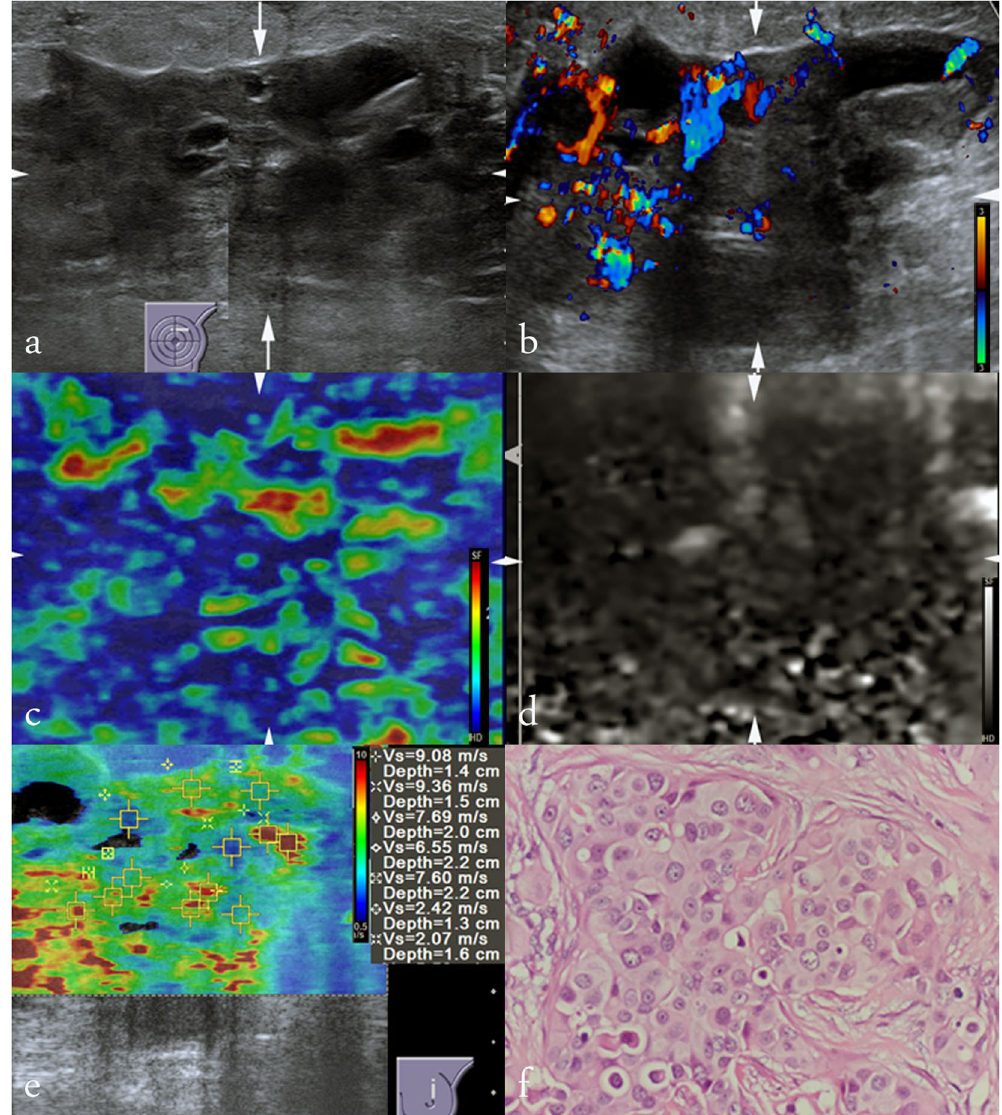
Figure 2. Images in a 42-years-old woman with invasive ductal carcinoma. At conventional US, an 68-mm breast lesion at 12 o’clock position of the left breast appears to be predominately solid, irregular shape, not parallel in orientation, not circumscribed margin, heterogeneous, enhancement in posterior acoustic features, present of internal vascularity, absence of calcification, and is finally classified as BI-RADS category 5, ( a ) and ( b ). At elastography, SE score of 4 ( c ), pattern 4b in VTI ( d ), and SWS max of 9.36 m/s, SWS median of 7.60 m/s, SWS mean of 6.40 m/s, SWS min of 2.07 m/s ( e ) are occurred. Histologic specimen (hematoxylin-eosin stain; original magnification, × 200) confirms a diagnosis of invasive ductal carcinoma ( f